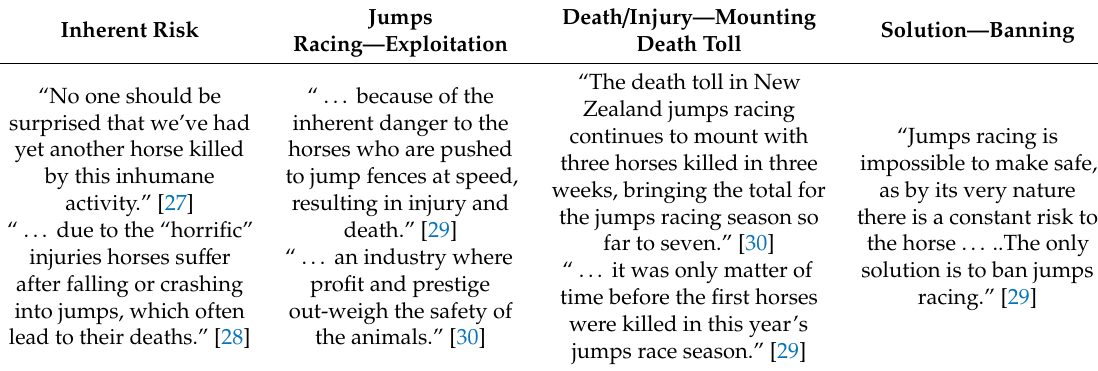
Table 2. Arguments from eight articles opposed to New Zealand jumps racing published between May 2016–August 2018.